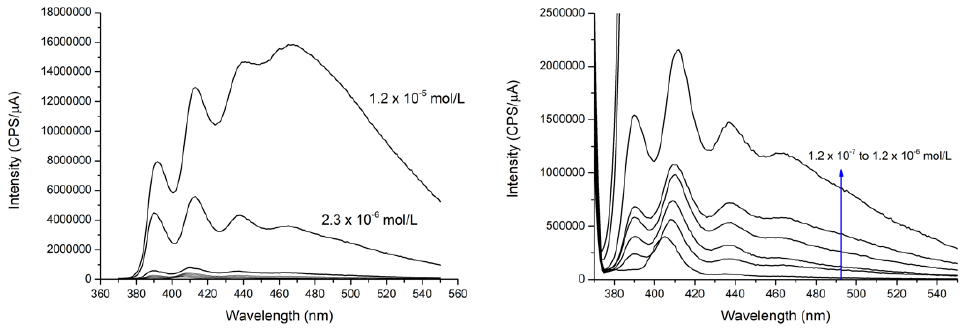
Figure 6. Emission spectra of [Mn III ] in ethanol with concentrations from 1.2 × 10 −5 to 1.2 × 10 −8 mol/L. Excitation wavelength: 362 nm. All spectra were recorded with two different spectrometers settings one adapted to the highest concentrations, the other to the lowest ones. The spectra dis- played are the ones with the best resolution to saturation ratio, hence the change of unit scale.